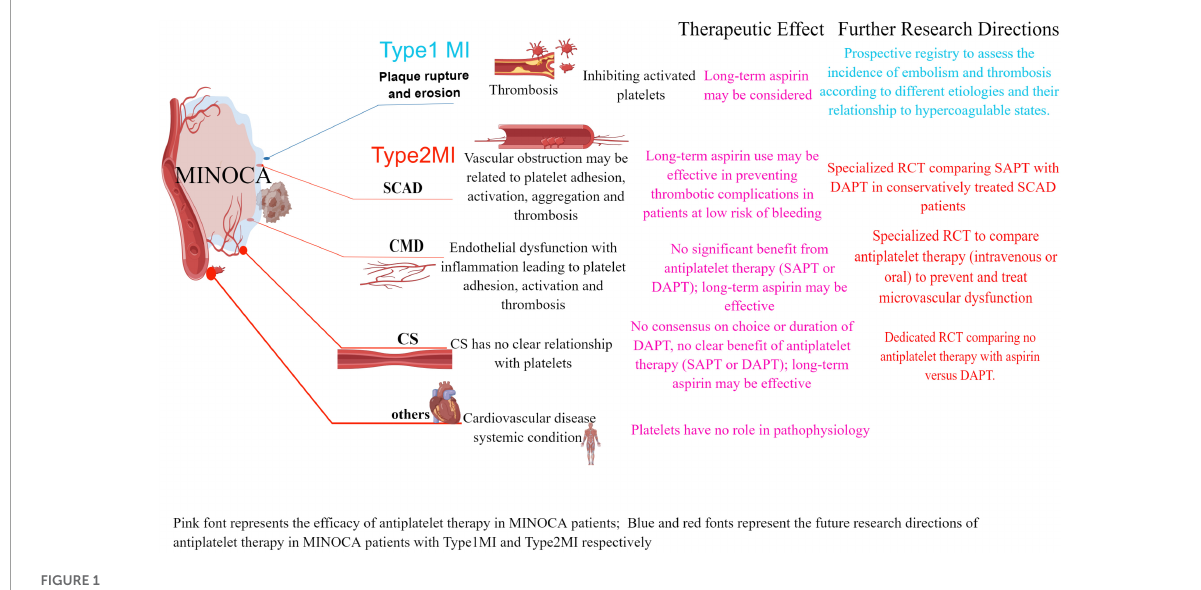
FIGURE1 The role of antiplatelet agents in the main etiology of MINOCA according to the 4th UDMI classification, further research directions: dedicated RCTs to evaluate the use of antiplatelet therapy (type, dose, and duration) and its association with the etiology of MINOCA in prospective clinical studies. MINOCA, myocardial infarction with non-obstructive coronary arteries; UDMI, universal myocardial infarction definition; MI, myocardial infarction; SCAD, spontaneous coronary artery dissection; CS, epicardial coronary spasm; CMD, coronary microvascular disease.